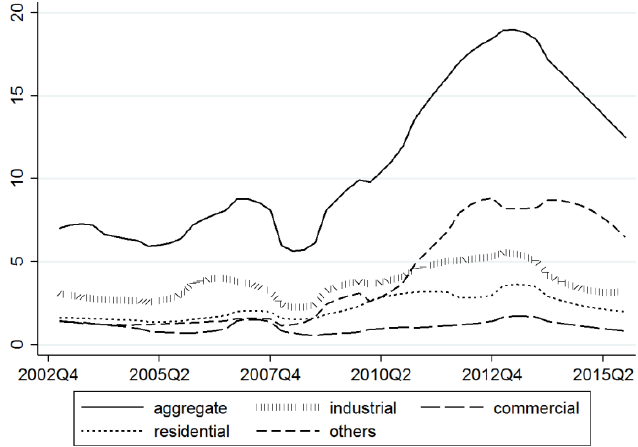
Figure 2. Various types of land supply (measurement: 10,000 hectares).